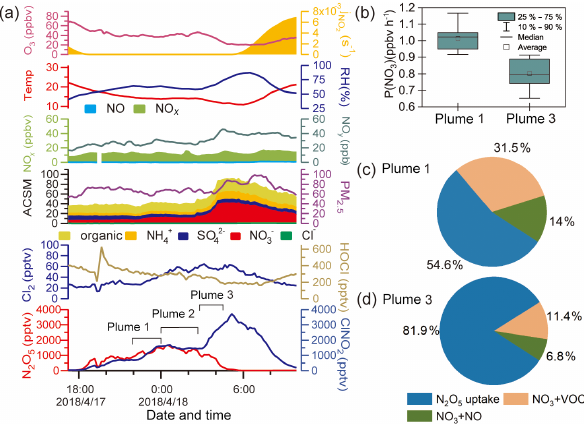
Figure 3. Detailed analysis of a high-ClNO 2 episode observed on 17–18 April. (a) Time series of ClNO 2 and related species. (b) – (d) Comparisons of P (NO 3 ) and NO 3 loss pathways in plumes 1 and